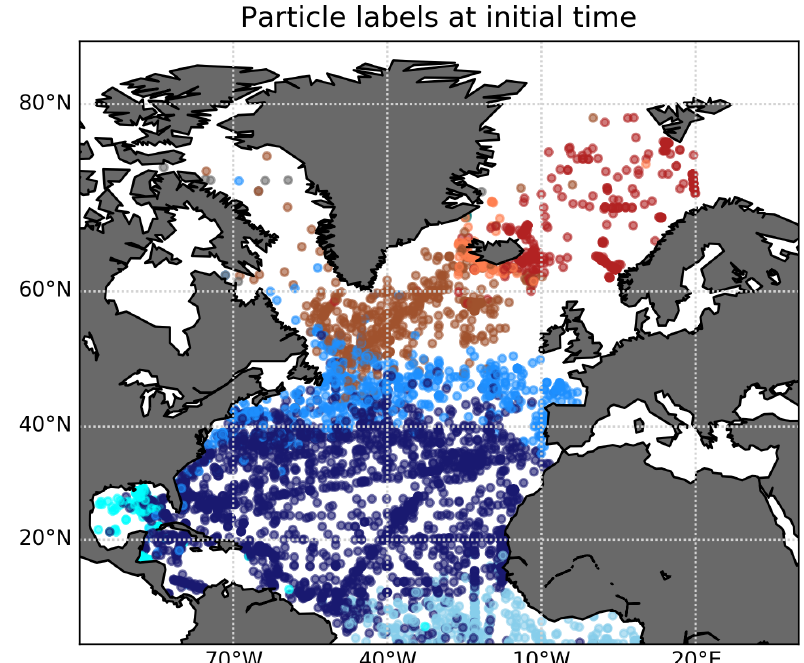
Figure C1. Clustering of Q for the drifter data set with (cid:49)x = (cid:49)y = 1 ◦ and no restriction on trajectory length, plotted at the drifter release location. Some main features as seen in Fig. 6 are still visible, but some details disappear. The hierarchical clustering was stopped at an NCut value comparable to the maximum NCut in Fig. 6, i.e. about 3.8.